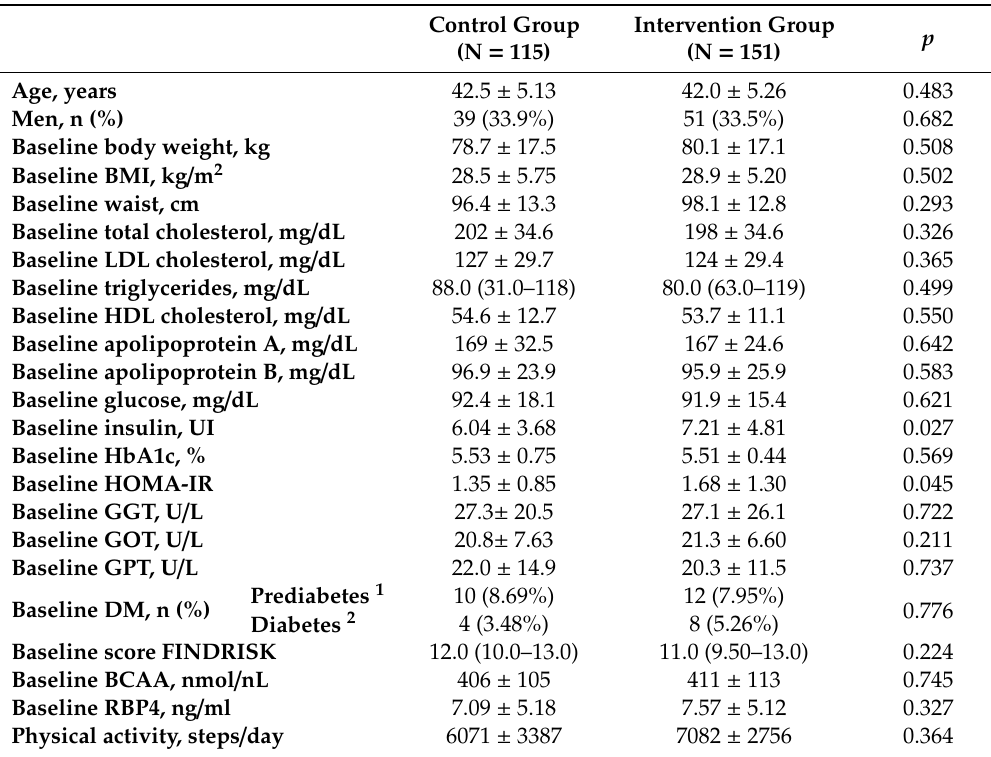
BMI: body mass index. LDL: low density lipoprotein. HDL: high density lipoprotein. HOMA: homeostatic model assessment. GGT: gamma-glutamyl transferase. GOT: glutamic oxaloacetic transaminase. GPT: glutamic-pyruvate-transaminase. HbA1c: glycatedhemoglobin. BCAA:branchedaminoacid. RBP4: retinol-binding protein 4. Physical activity was measured as the total steps per day. Quantitative variables are expressed